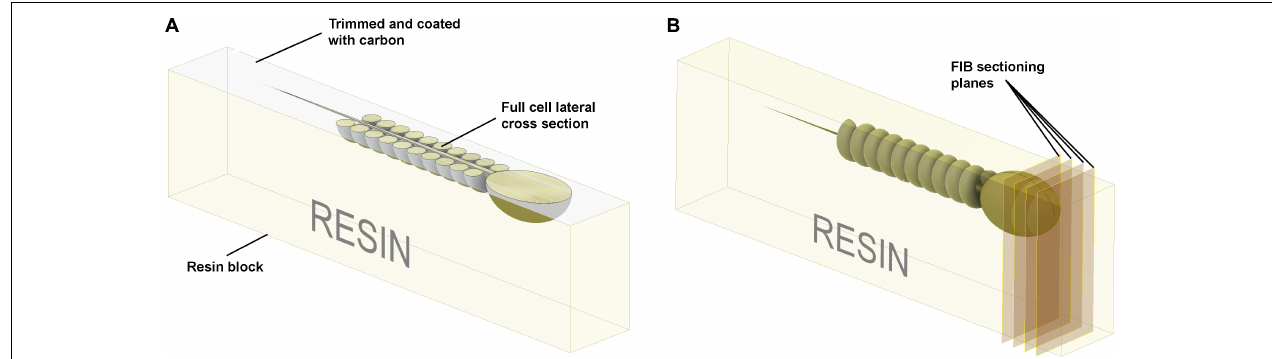
FIGURE 5 | Schematic illustration of the preparation of resin embedded cell monolayer. The top surface is formed by detaching the sapphire disk from the resin block; thus, it is smooth, and the cells are localized precisely on the surface. (A) For the visualization of full cell cross-sections, a layer of resin about half the thickness of the cell should be trimmed off with an ultra-microtome using a diamond knife, and the surface coated with ∼ 10 nm of carbon. The cross-sections can then be visualized with SEM in backscattering electron mode. (B) To collect focused ion beam scanning electron microscope (FIB-SEM) volume data the ion beam serially removes thin layers from the block face